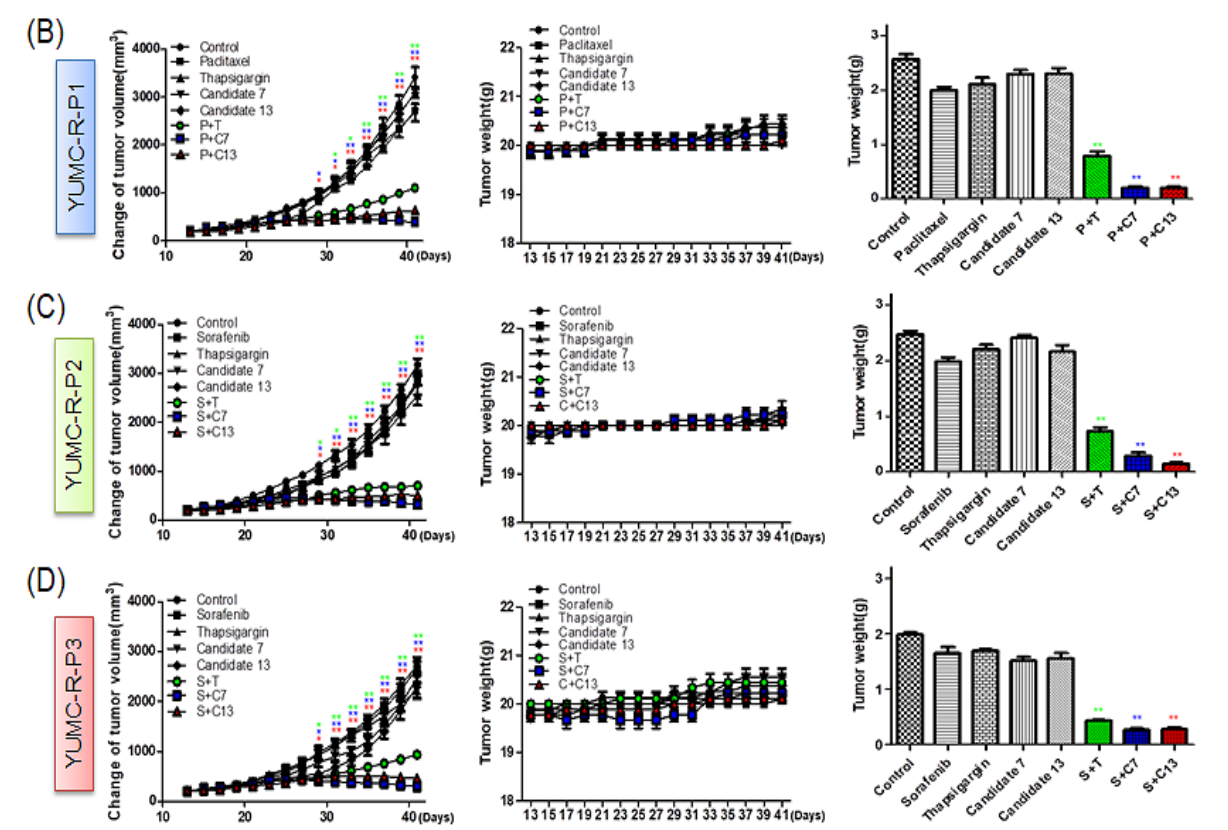
Figure 6. Combination of novel SERCA inhibitors with paclitaxel or sorafenib has the highest anticancer efficiency, inducing a higher tumor shrinkage in patient-derived antineoplastic-resistant PTC cells, YUMC-R-P1, -P2, and -P3 in vivo than in sensitive cells (YUMC-S-P1). ( A – D , left ). Changes in the tumor volume; ( A – D , right ). The weight of the resected tumor; ( A – D , middle ). Changes in whole body weight (each group, n = 10). Tumors were evaluated in NOD/Shi-scid, IL-2R γ KOJic (NOG) mice and animals were treated with paclitaxel or sorafenib combined with novel SERCA inhibitors, candidates 7 or 13, or with each agent alone. Data represent the mean ± standard error of the mean. * p < 0.05 and ** p < 0.01, compared with control. *,** paclitaxel or sorafenib + thapsigargin versus control, *,** paclitaxel or sorafenib + candidate 7 versus control, *,** paclitaxel or sorafenib + candidate 13 versus control.